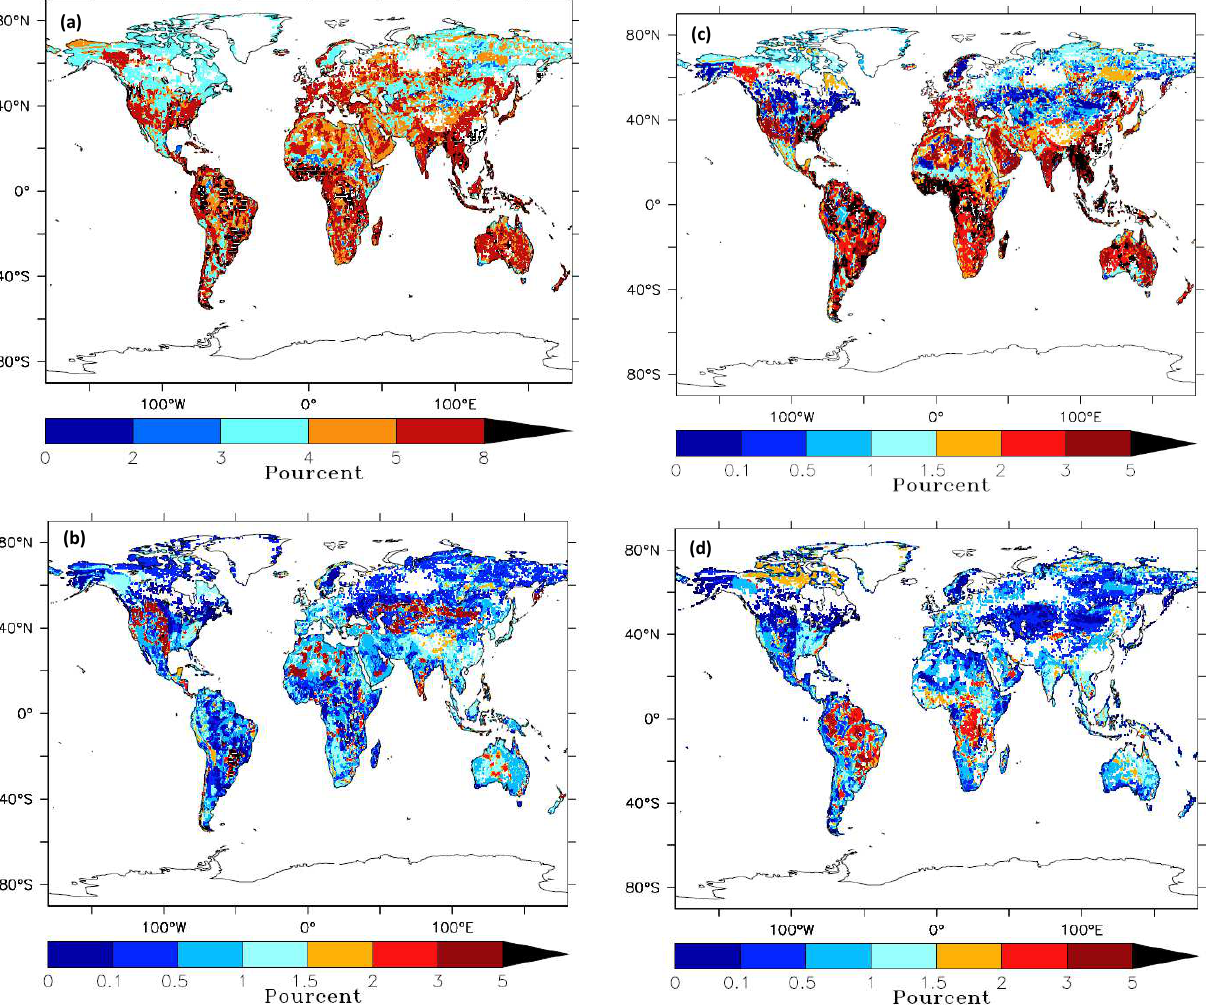
Fig. 7. Iron and iron oxides in soils: (a) iron in the clay fraction (CASE 1), (b) hematite in the clay fraction (CASE 1), (c) goethite in the clay fraction (CASE 1) and (d) goethite in the silt